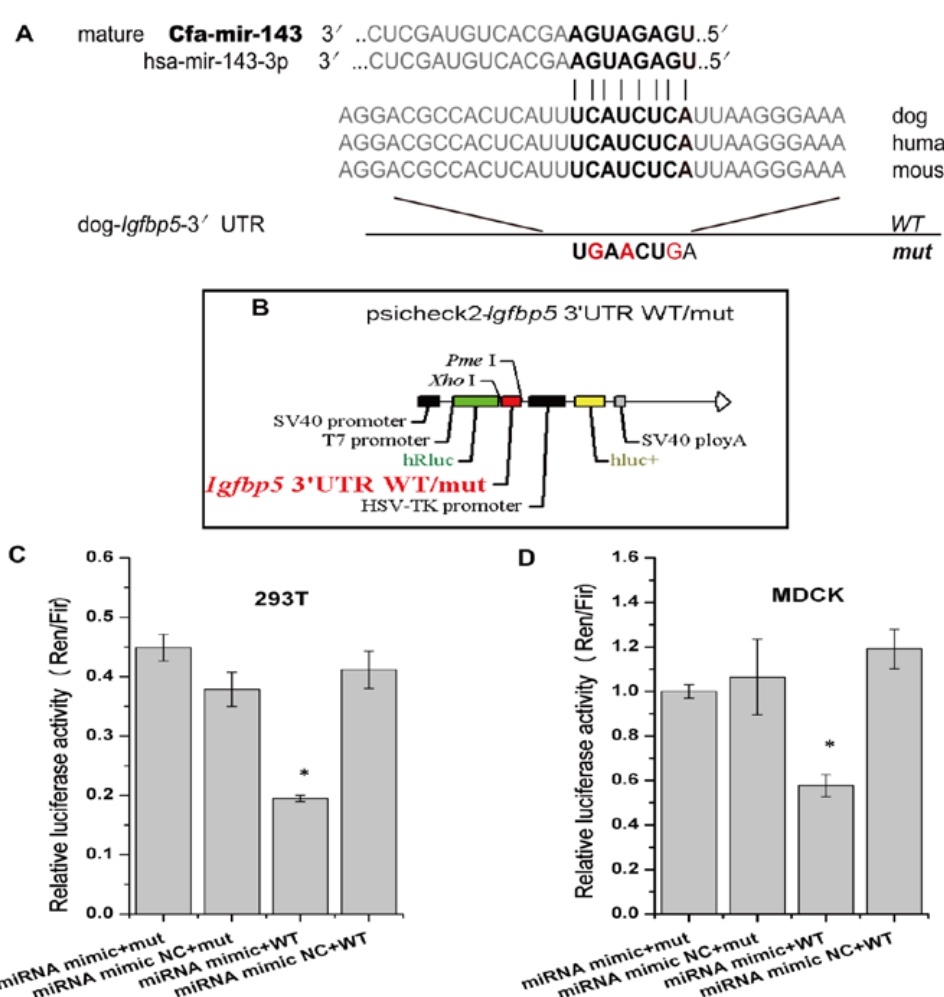
Figure 2. cfa-miR-143 targets the Igfbp5 gene. ( A ) A mutation in the 3 (cid:48) -UTR of the Igfbp5 gene was designed in a seed sequence site for binding with cfa-miR-143. The inserted mutation is marked (red); ( B ) The WT (wildtype) and mut (mutation) genes were inserted into a dual fluorescence reporter retroviral vector (psicheck-2). The insertion was ligated between the human Renilla luciferase (hRlu) gene and the promoter of the human firefly luciferase (hFlu) gene. The recombined plasmids, psicheck2-Igfbp5 3 (cid:48) UTR WT and psicheck2-Igfbp5 3 (cid:48) UTR mut, were transfected into 293T and MDCK cells along with cfa-miR-143 mimic or mimic NC (Negative Control); ( C , D ) Detection of relative luciferase activity showed that the hRlu/hFlu ratio was significantly lower ( p < 0.05) in cells co-transfected with mimic and WT than in those with mimic and mut in both 293T and MDCK cells. Differences were considered statistically significant at p < 0.05. HSV-TK: herpesvirus thymidine kinase. Differences in expression levels were considered significant if p < 0.05 (* p <